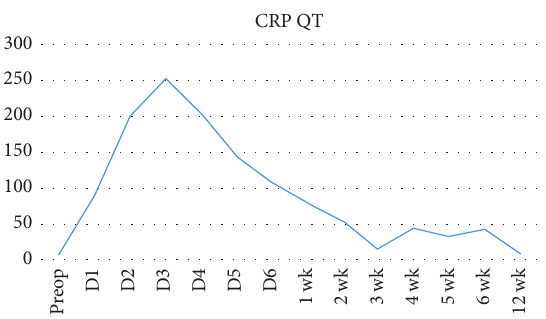
Figure 5: C-reactive protein levels from preoperation to 12 weeks after endovascular aneurysm repair (EVAR) by using the sandwich